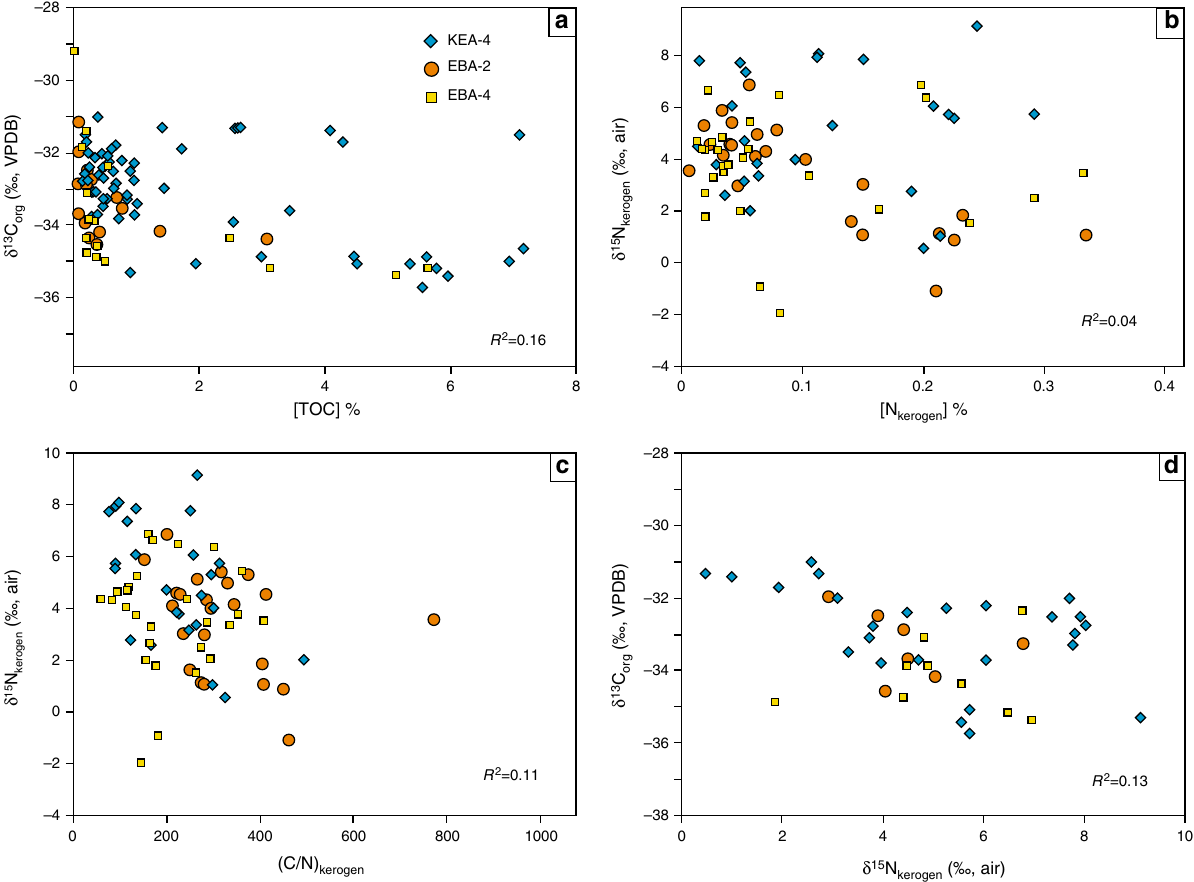
Fig. 4 Cross-plots of the elemental and isotopic data. a TOC relative to δ 13 C org , b δ 15 N kerogen versus nitrogen content in kerogen ([N] kerogen %), c δ 15 N kerogen relative to C/N atomic ratio of kerogen (C/N) kerogen and d red circles and yellow squares denoting cores KEA-4, EBA-2 and EBA-4,